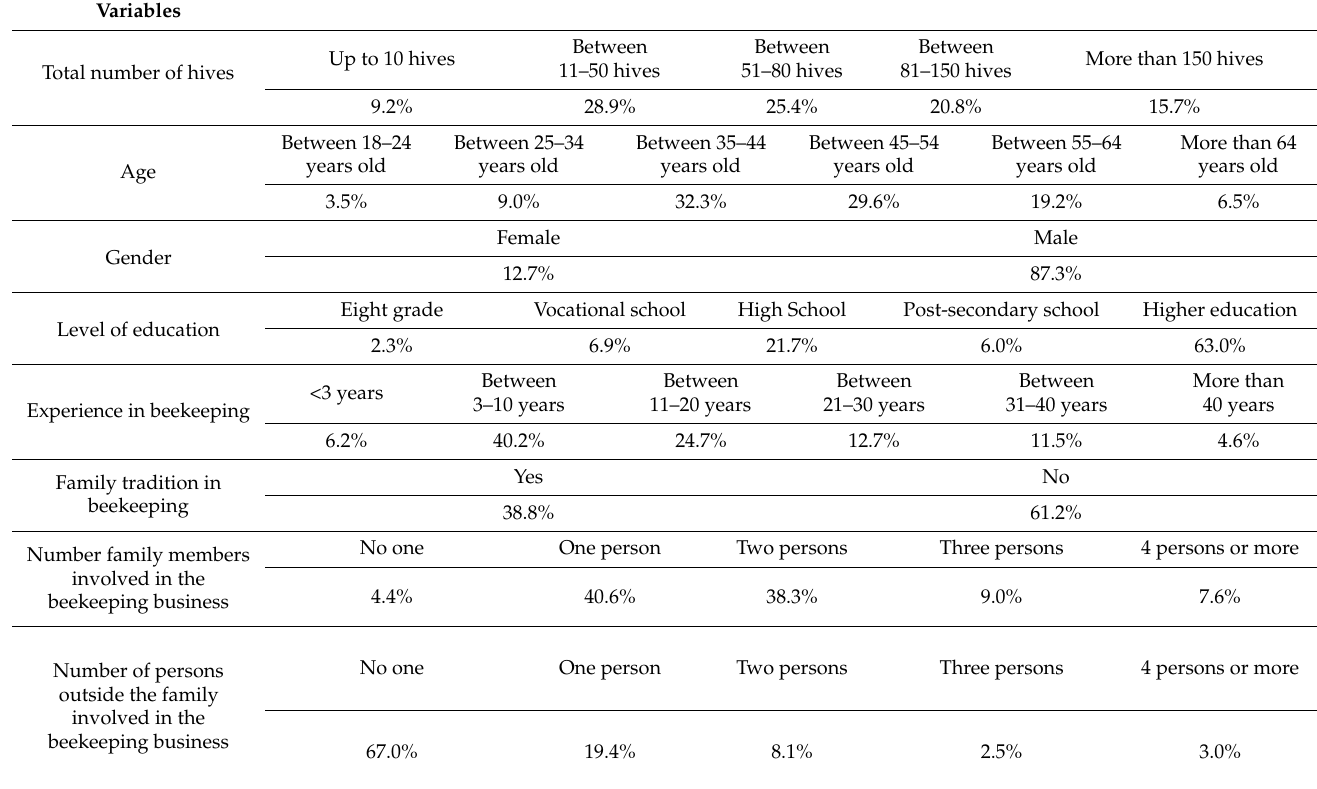
Table 1. Characteristics of the surveyed